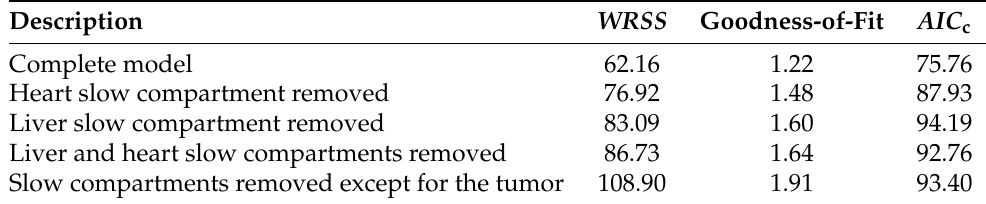
Table 4. Example of some of the simplifications that were tested (with slow components removed for some organs), and their WRSS , goodness-of-fit, and Akaike Information Criterion